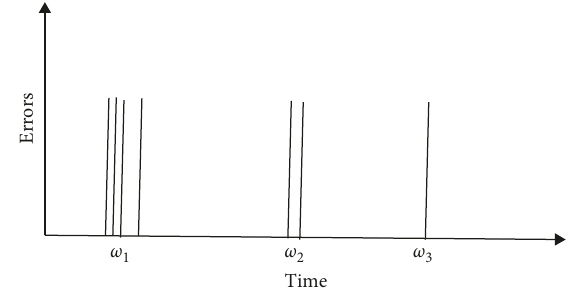
Figure 6: Error windows in time. Table 2: Corresponding Ψ ec calculation for three